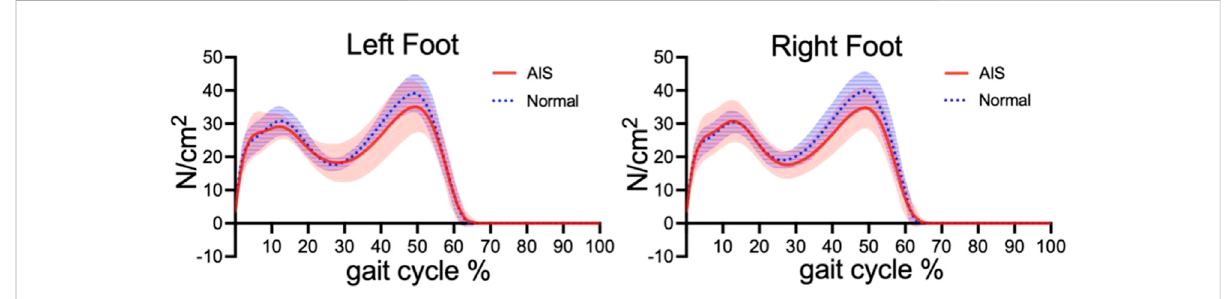
FIGURE 4 Bipedalmaximumpressurecurvesofthetwogroupsduringgaitcycle.RedindicatesAdolesceIdiopathicScoliosis(AIS)groupandBlueindicates normalgroup. Thesolidlineindicatesthmaximumpressurecurve,andtheshadedareaisthestandarddeviation. Expectfor the fi rstpeakoftheright foot, the peak value of AIS group is lower than that of the normal group.